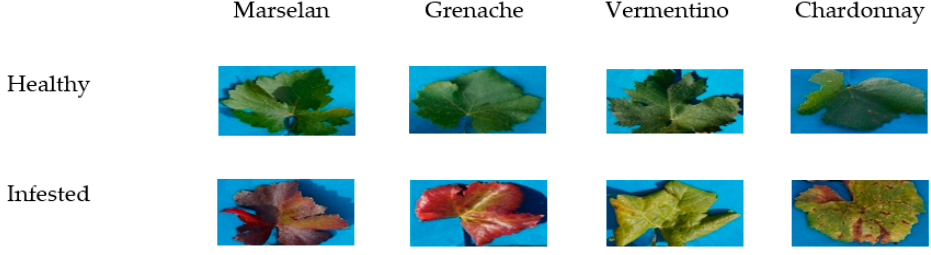
Figure 8. Configuration of analyzed data, infested against healthy groups for a binary classification.